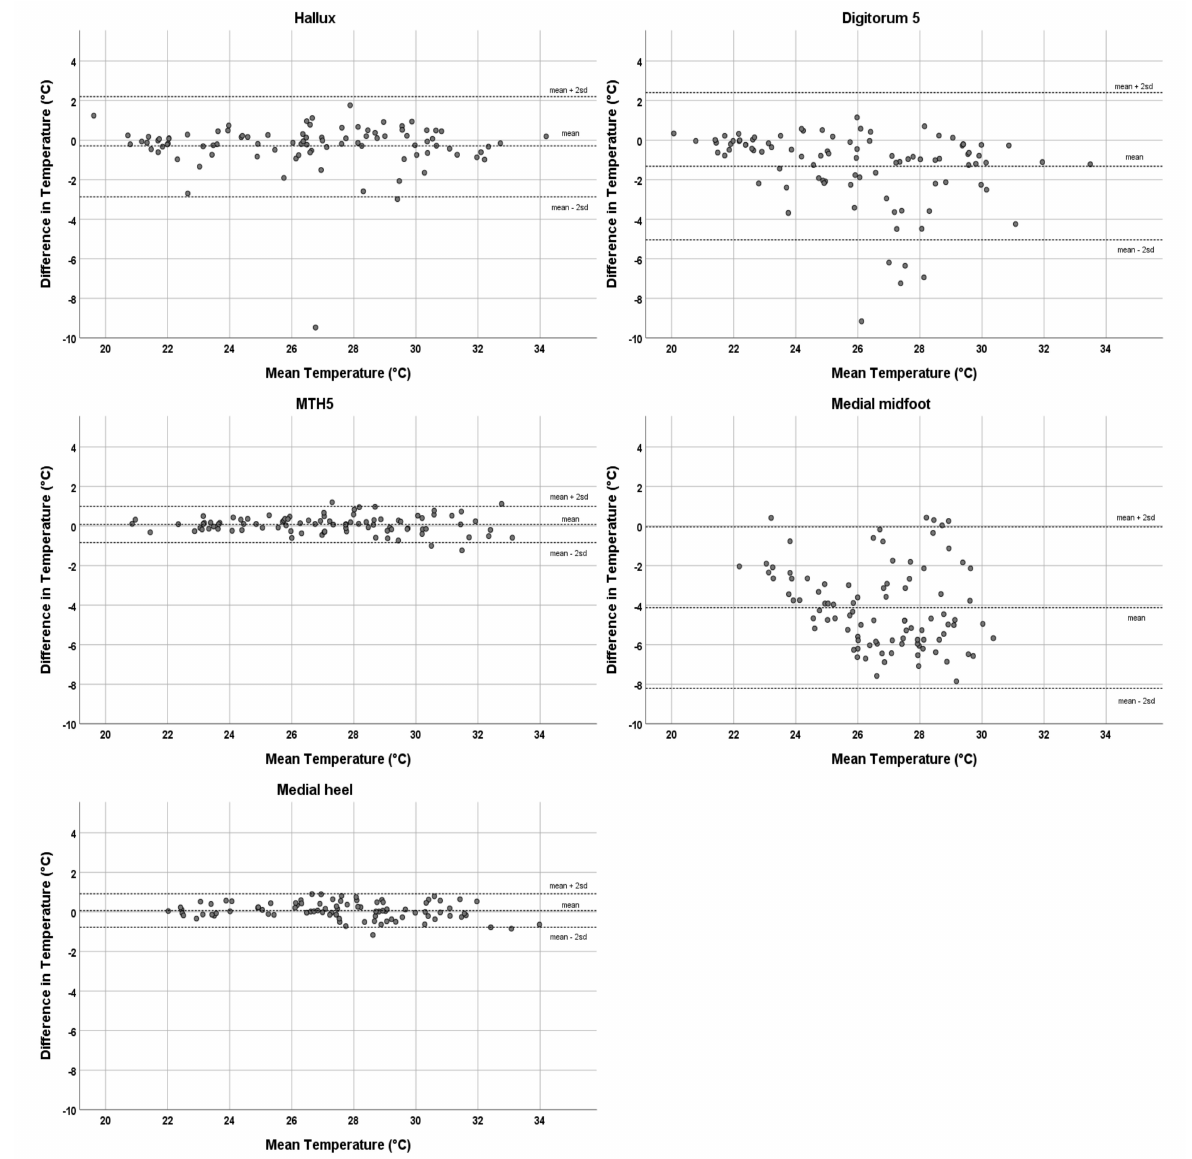
Figure 3. Bland–Altman plots with limits of agreement (i.e., mean ± 2sd) for measured temperature between the platform system and handheld thermometer for the hallux, digitorum 5, MTH5, medial midfoot, and medial heel. In these plots, the temperature difference between assessments (assessment platform system—assessment handheld thermometer) is shown against the average of both